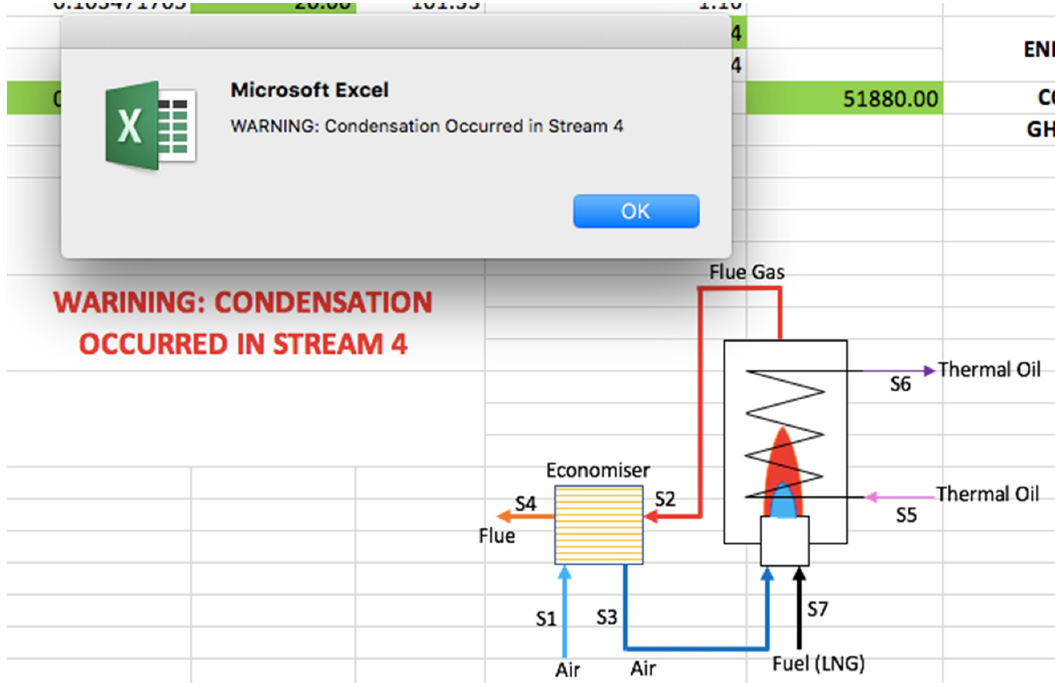
Figure A2. Warning when condensation of Flue Gas occurred.